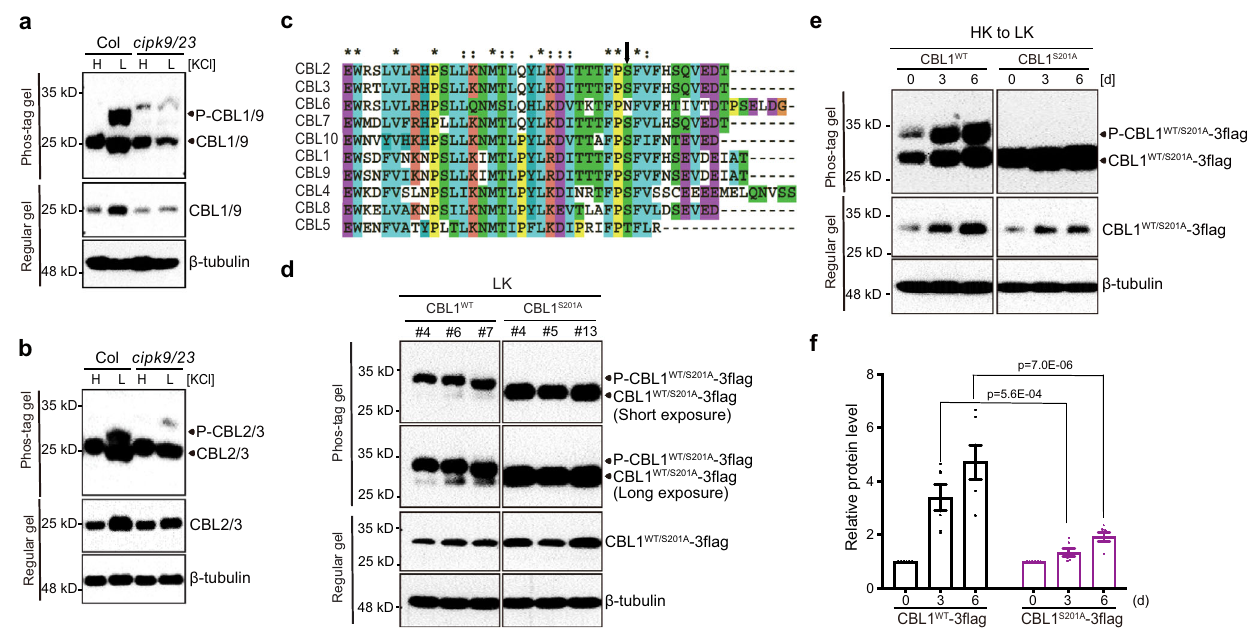
Fig. 2|CIPK9/23areresponsiblefor enhanced phosphorylationlevelsofCBL1/ 9/2/3proteinsunderlow-K + stressandCBL1/9phosphorylationcontributesto protein accumulation under low-K + stress. a , b Phosphorylation levels of CBL1/9 ( a )andCBL2/3( b )inColand cipk9/23 doublemutantgrownunderhigh-K + (20mM) or low-K + (10 μ M) for 7 days. c Amino acid sequence alignment of the C-terminus among ten Arabidopsis CBL members. The alignment is generated with Clustal X software.S201siteisindicatedbyablackarrow. d PhosphorylationstatusofCBL1 WT − 3 fl ag or CBL1 S201A − 3 fl ag under low-K + stress. Transgenic plants expressing fl ag- tagged CBL1 wild type (CBL1 WT ) or site-directed mutant CBL1 S201A in the cbl1cbl9 background were grown under low-K + (10 μ M) condition for 10 days. Three inde- pendent transgenic lines were used in each case. Each immunoblot result is the representativeofatleastthreerepeats. e Phosphorylationstatusandproteinlevels